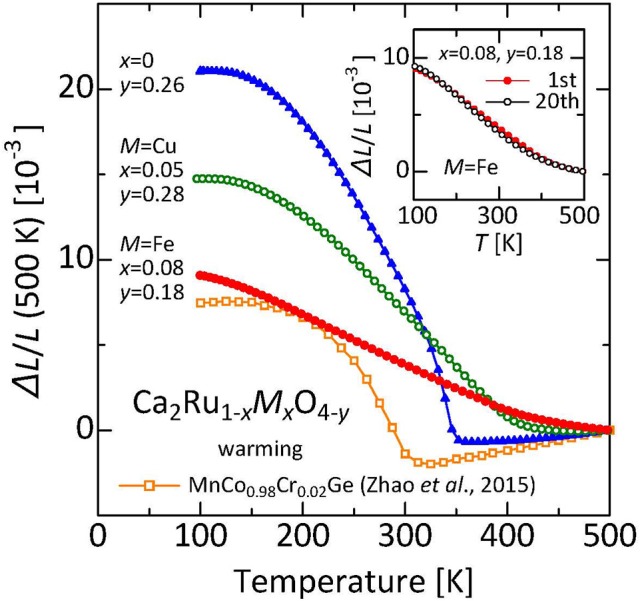
Linear thermal expansion of Ca2Ru1−xMxO4−y (M = Fe, Cu). Reference temperature: 500 K. Inset: Linear thermal expansion ΔL/L of Ca2Ru0.92Fe0.08O3.82 before and after 20 iterations of thermal cycling (reference temperature: 500 K). Data related to the warming process were collected using a laser interference dilatometer. Referred from earlier reports (Takenaka et al., 2017a,b). For comparison, data of MnCo0.98Cr0.02Ge (Zhao et al., 2015) are also shown.